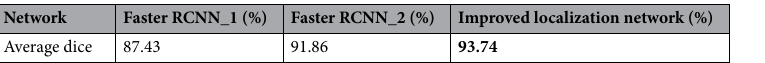
Table 3. Comparison of localization network performance. Significant values are in bold.